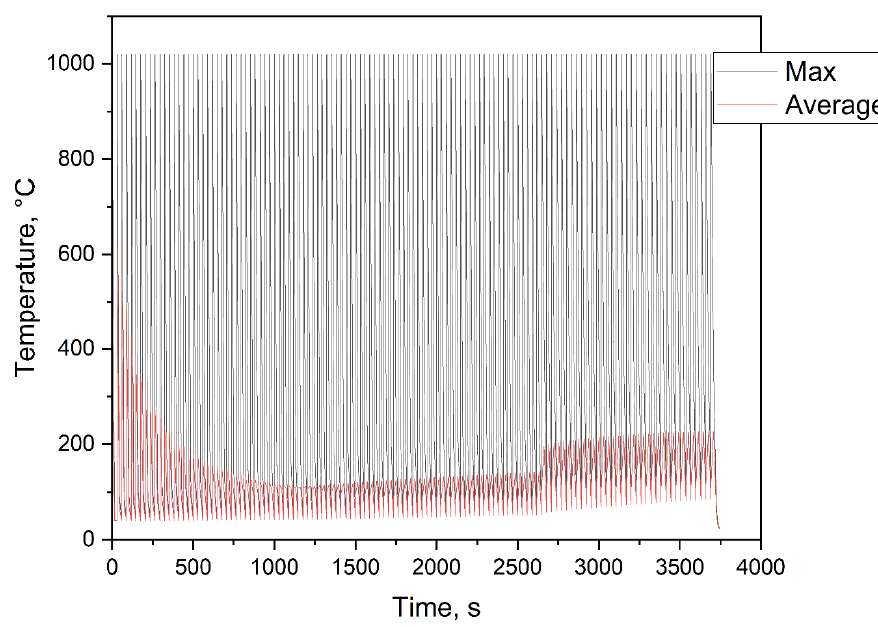
Figure 10. Thermal curve during the simulated production.